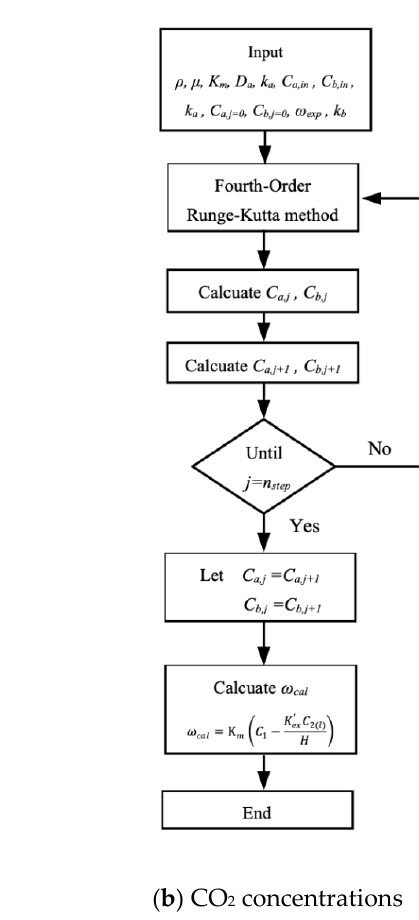
Figure 6. Calculation flow chart for determining the diffusion coefficient and CO 2 concentrations in gas and liquid phases under cocurrent-flow operations.